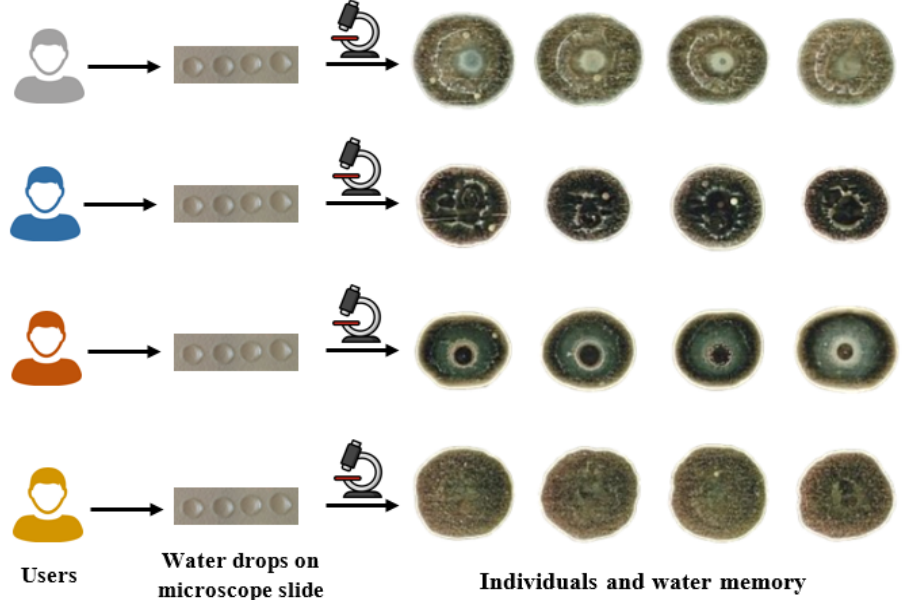
Figure 1. Experiment- Waterdrops on a microscope slide, individuals and water